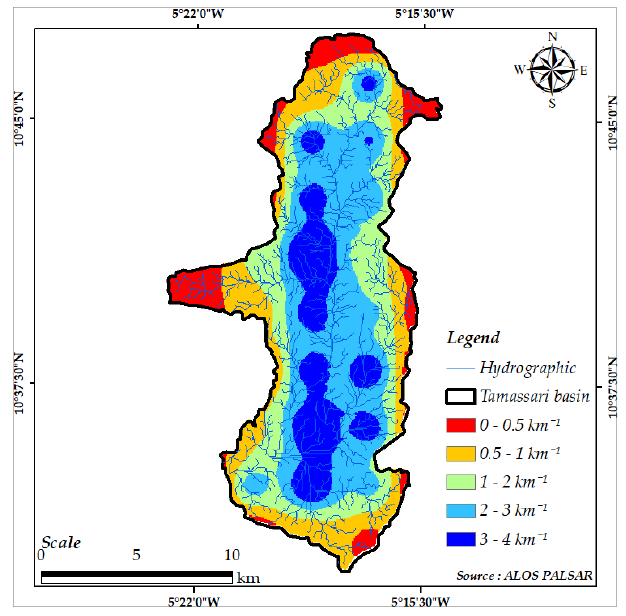
Figure 9. Hydrographic network density mapping.